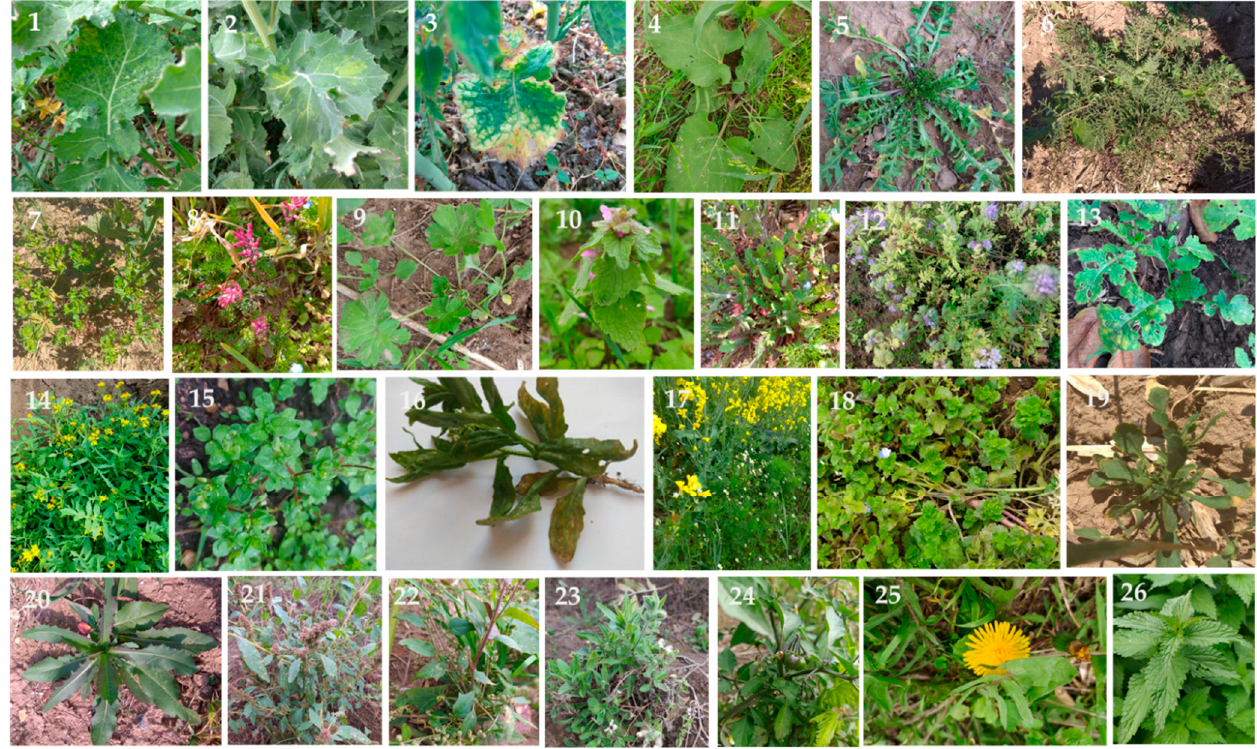
Figure 2. Oilseed rape, intercrops and weed species infected by TuYV. ( 1 – 3 ): Brassica napus, ( 4 ):